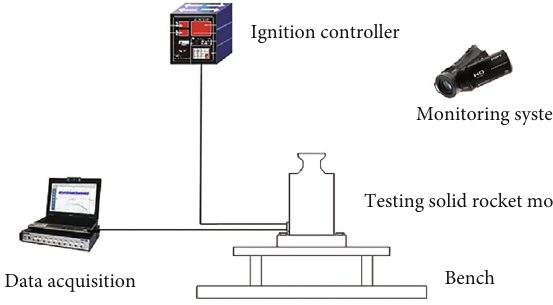
Figure 2: Ground fi ring test system.